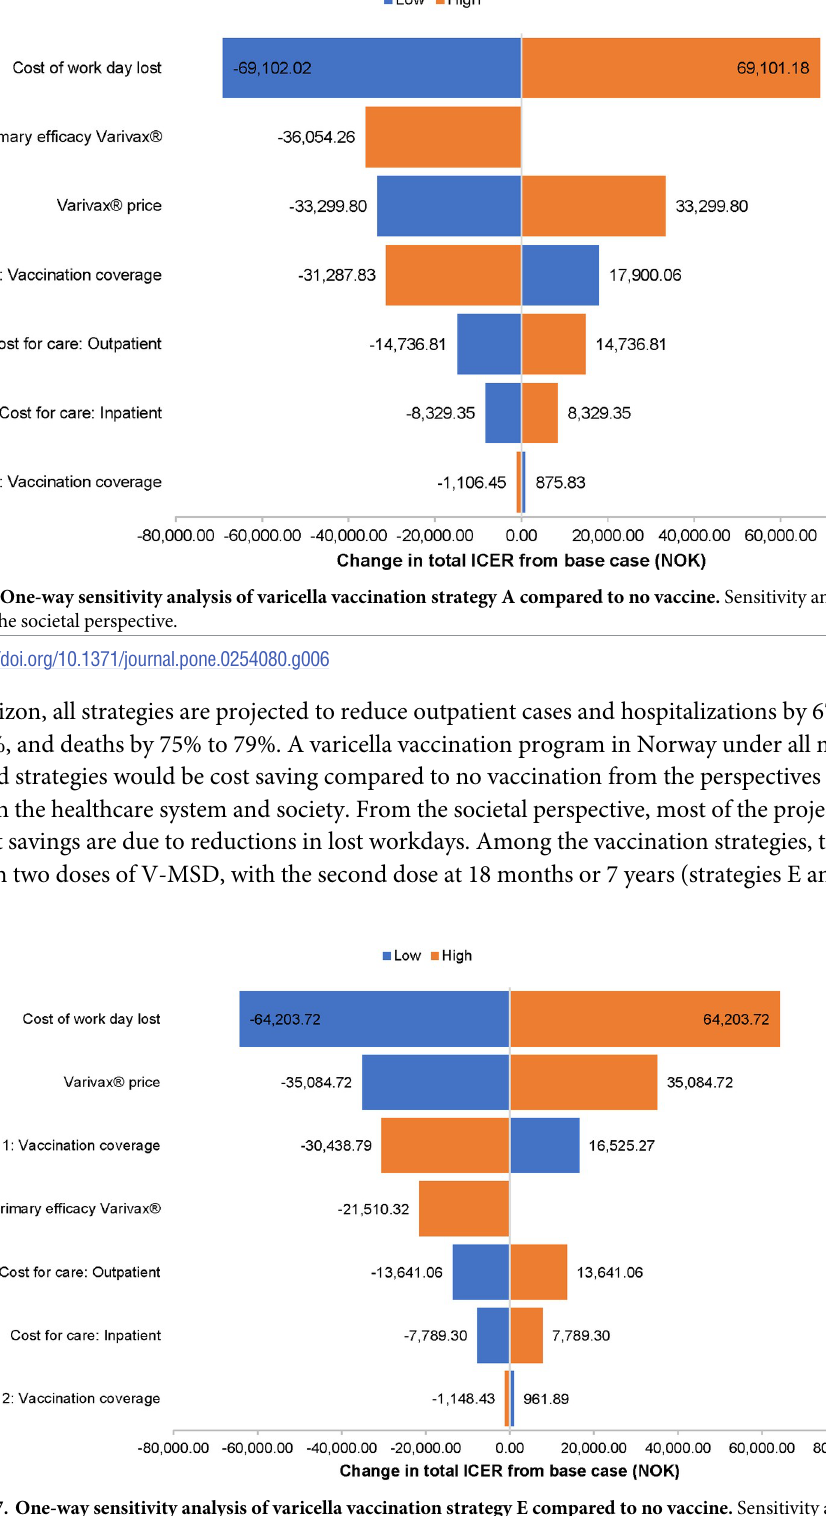
Fig 7. One-way sensitivity analysis of varicella vaccination strategy E compared to no vaccine. Sensitivity analysis from the societal perspective.